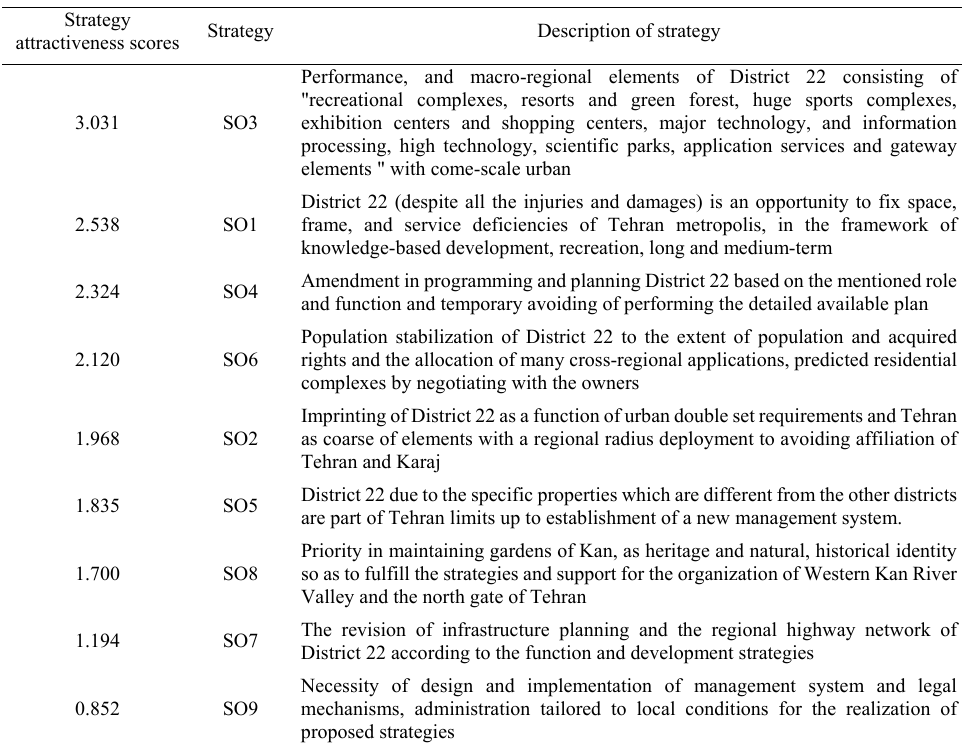
Fig. 3: Strategy tending based on IFEM and EFEM Table 7: Priorities of the executive strategies